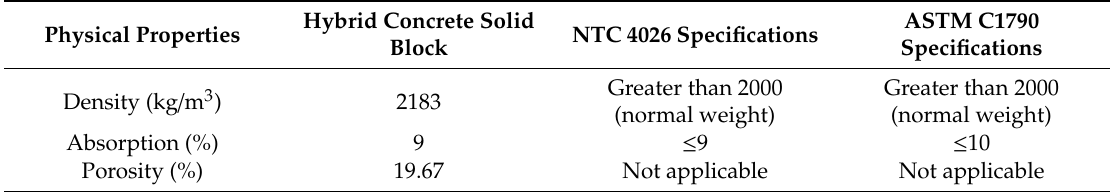
Table 7. Physical properties of the hybrid concrete solid blocks in relation to the specifications established by the standards as high-class structural blocks.